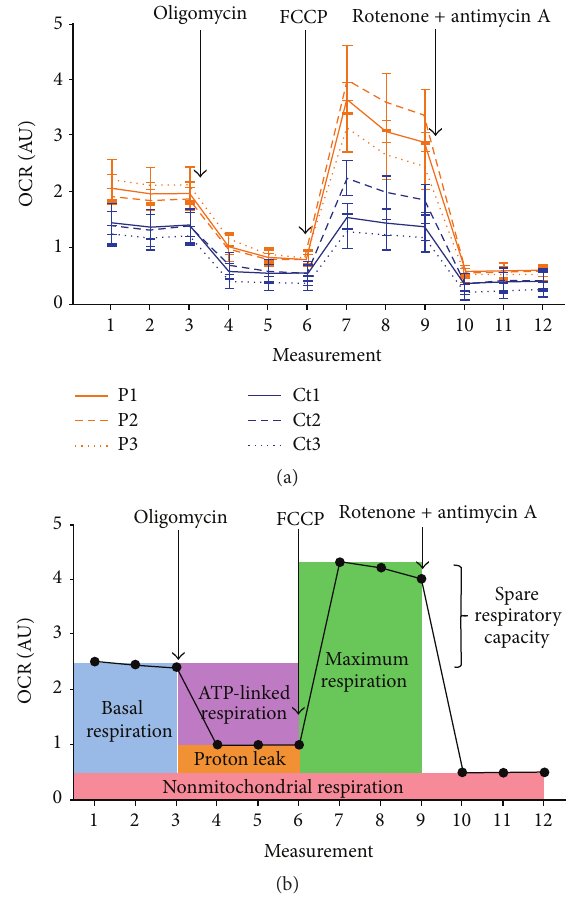
Figure 1: Respiratory flux profiles of patient-derived and control fibroblasts, as determined by a Seahorse Extracellular Flux Ana- lyzer with twelve consecutive measurements of oxygen consump- tion rate (OCR). Addition of ATP synthase inhibitor oligomycin, electron transport chain uncoupler FCCP and complex I and III inhibitors rotenone and antimycin A are indicated. (a) Res- piratory flux profiles of patient-derived and control fibroblasts. Results are expressed as mean ± SEM. (b) Illutrative respira- tory flux profile indicating various parameters of respiratory con- trol. These include: OCR due to non-mitochondrial respiration (rotenone/antimycin A response); basal mitochondrial OCR (basal measurement minus rotenone/antimycin A response); ATP-linked OCR (basal measurement minus oligomycin response); OCR due to proton leak (oligomycin response minus rotenone/antimycin A response); ATP coupling efficiency (basal mitochondrial OCR divided by ATP-linked OCR); maximum OCR (FCCP response minus rotenone/antimycin A response) and spare respiratory capac- ity (maximum OCR divided by basal mitochondrial OCR). AU, arbitrary units; Ct, control; OCR, oxygen consumption rate; P, patient; SEM, standard error of the